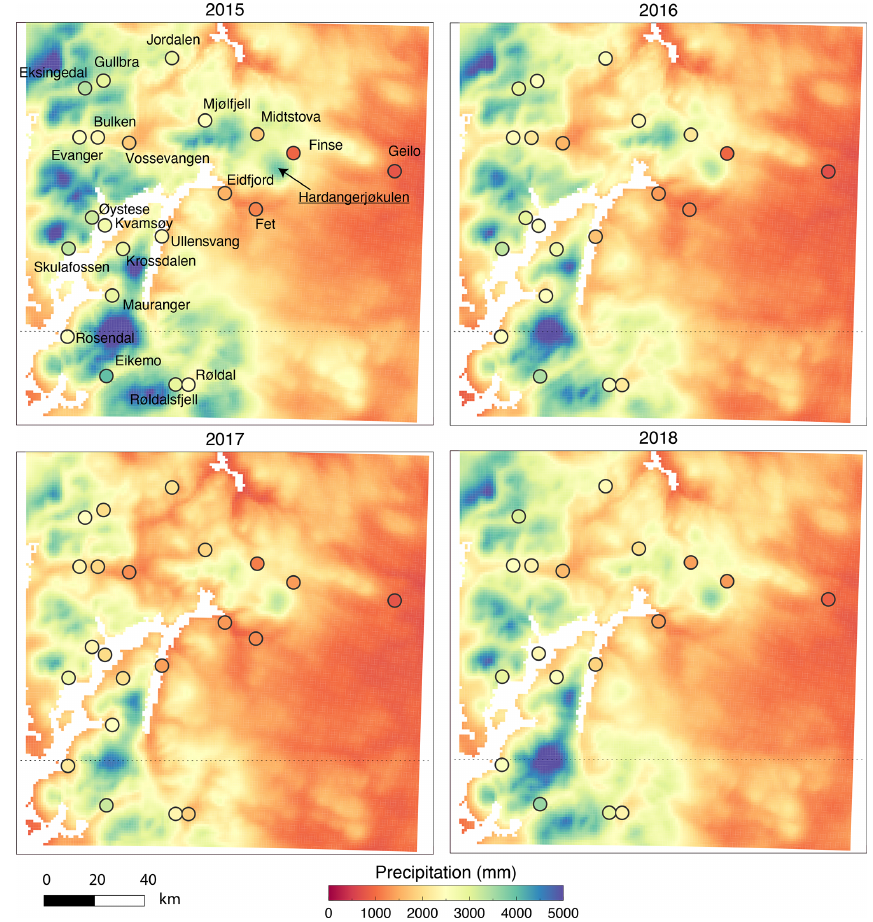
Figure 3. Simulated and observed precipitation (October–September) for mass balance years 2015–2018. Circles represent observations from automated weather stations (AWSs). The location of Hardangerjøkulen is also